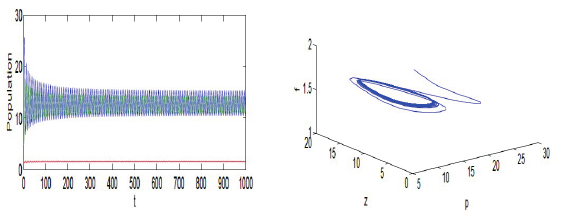
Fig. 3: Hopf bifurcating periodic orbits are stable around R * at τ =